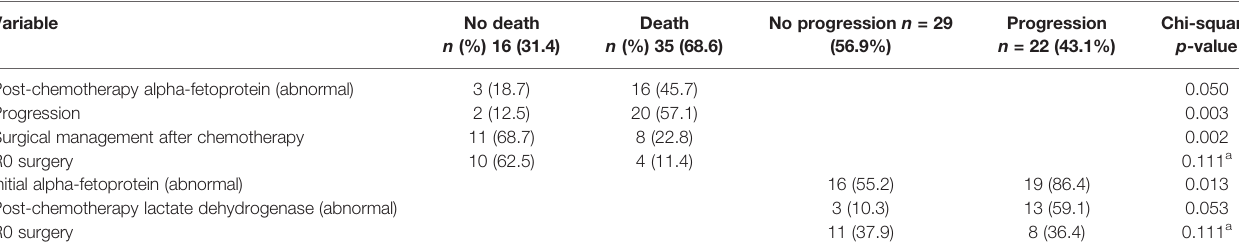
TABLE 3 | Chi-square test analysis for non-seminomatous germ cell tumors overall survival and progression-free survival.